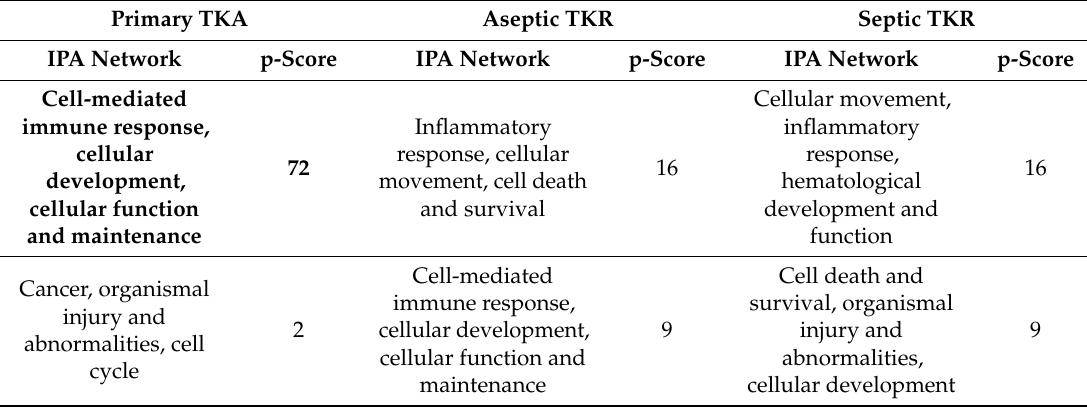
Figure 6. Ingenuity Pathway Analysis (IPA)-generated networks for primary TKA, aseptic TKR, and septic TKR groups based on cytokine and phosphoprotein datasets. Proposed networks used relative cytokine and phosphoprotein responses in the ATL depth, illustrating the di ff erences in tissue responses for the three groups. The nodes are illustrated in a “heat map” coloring scheme, with red denoting up-regulation, green denoting down-regulation, and the intensity of color correlates to the intensity of relative response. The networks are supplemented with other nodes likely to be involved, as identified in the Ingenuity Knowledge Base. A solid line represents a direct interaction between two nodes, while a dotted line denotes an indirect relationship. Table 3. Top 2 IPA Networks for Primary TKA, Aseptic TKR, and Septic TKR Groups. Network p-scores are calculated by IPA using the negative log 10 ( p -value) of Fisher’s exact test. The p-value describes the probability of finding the cytokines / phosphoproteins randomly in the databases utilized by IPA to construct the network. Networks with p-scores above the threshold of 21 are bolded.